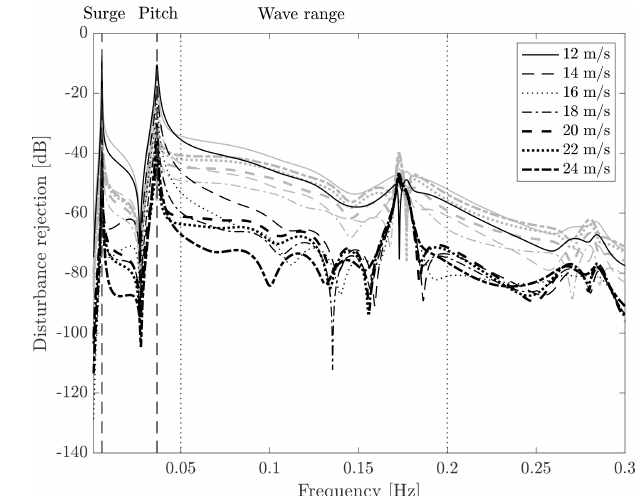
Figure 8. Disturbance rejection of the FBFF controller with (black) and without (grey) scheduling, for several above-rated operating conditions. The vertical dashed lines are the frequency of the plat- form surge and pitch modes; the frequency range where waves are active is enclosed by the vertical dotted